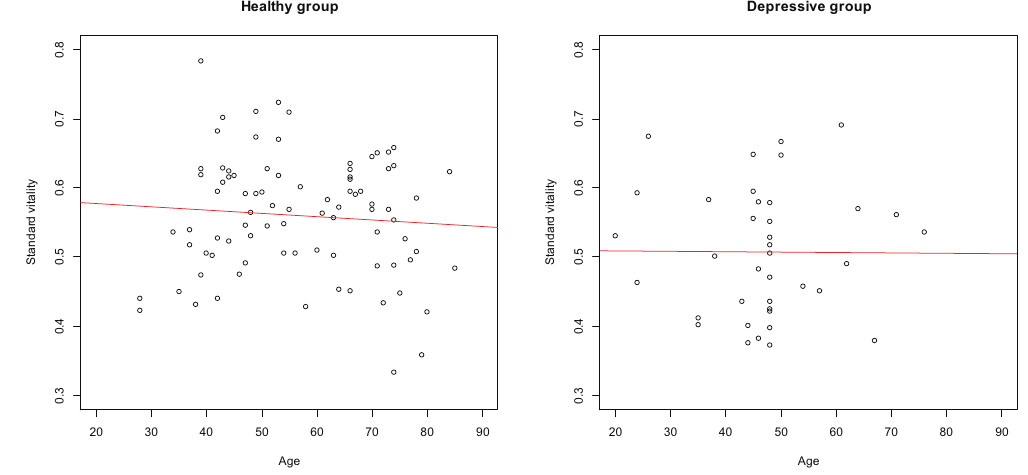
Figure 3. Scatter plots of age and standard